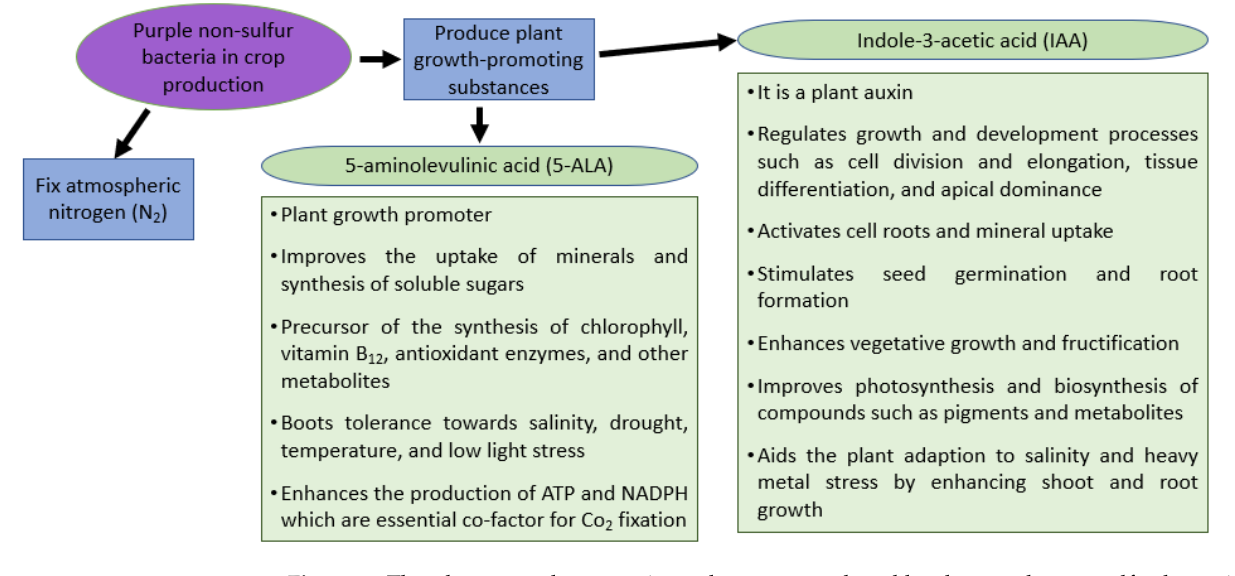
Figure 2. The plant growth-promoting substances produced by the purple non-sulfur bacteria to enhance plant growth and yield.